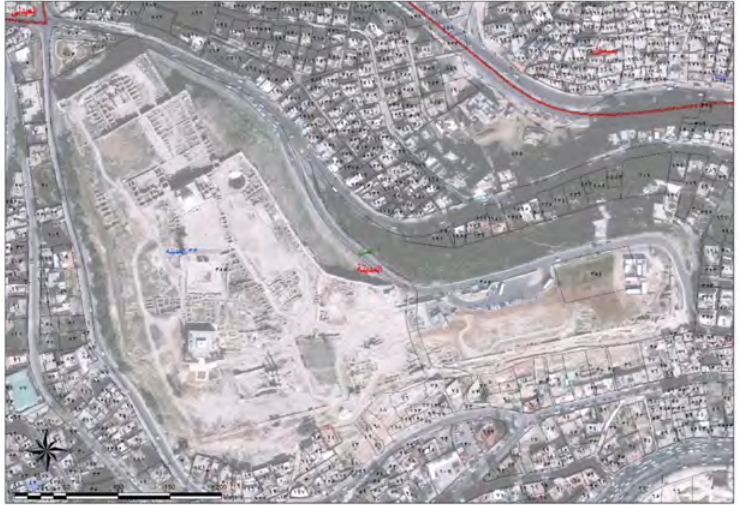
Figure 21. Prohibited area site aerial view map. Source: GAM- GIS for the author (2016).